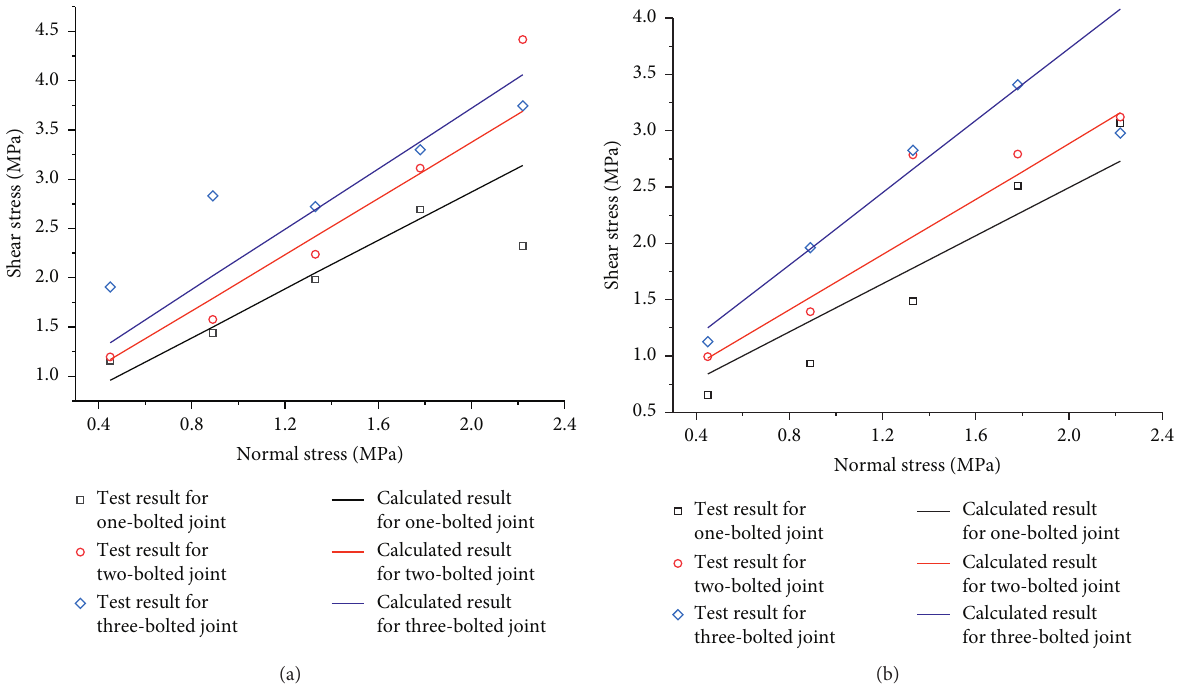
Figure 8: Comparison of test results with optimal calculated values. (a) 45 ° inclination. (b) 90 ° inclination.